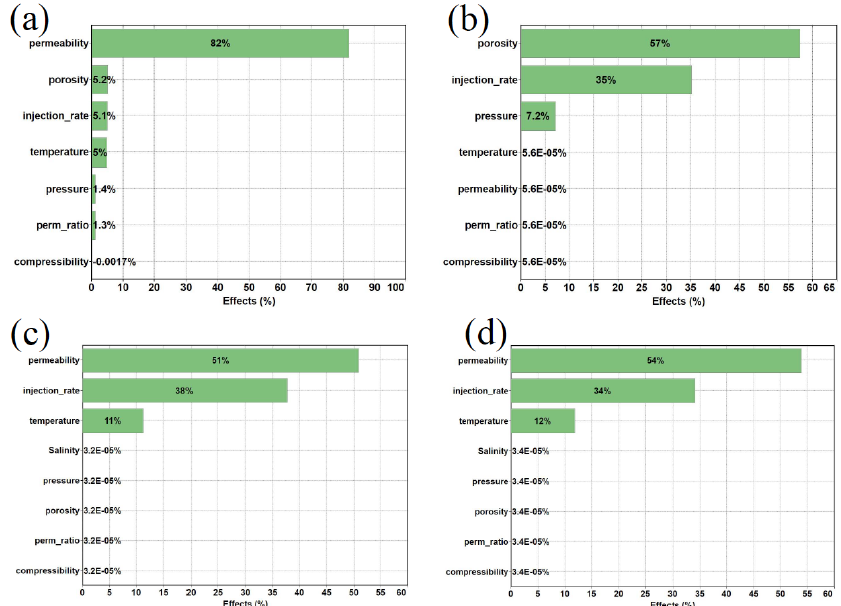
Figure 8. Sensitivity analysis using the Sobol method to estimate the percentage each factor contrib- utes to predicting pressure buildup: ( a ) bottomhole pressure buildup for supercritical CO 2 injection, ( b ) average reservoir pressure buildup for supercritical CO 2 injection, ( c ) bottomhole pressure buildup for low-salinity water injection, and ( d ) average reservoir pressure buildup for low-salinity water injection.